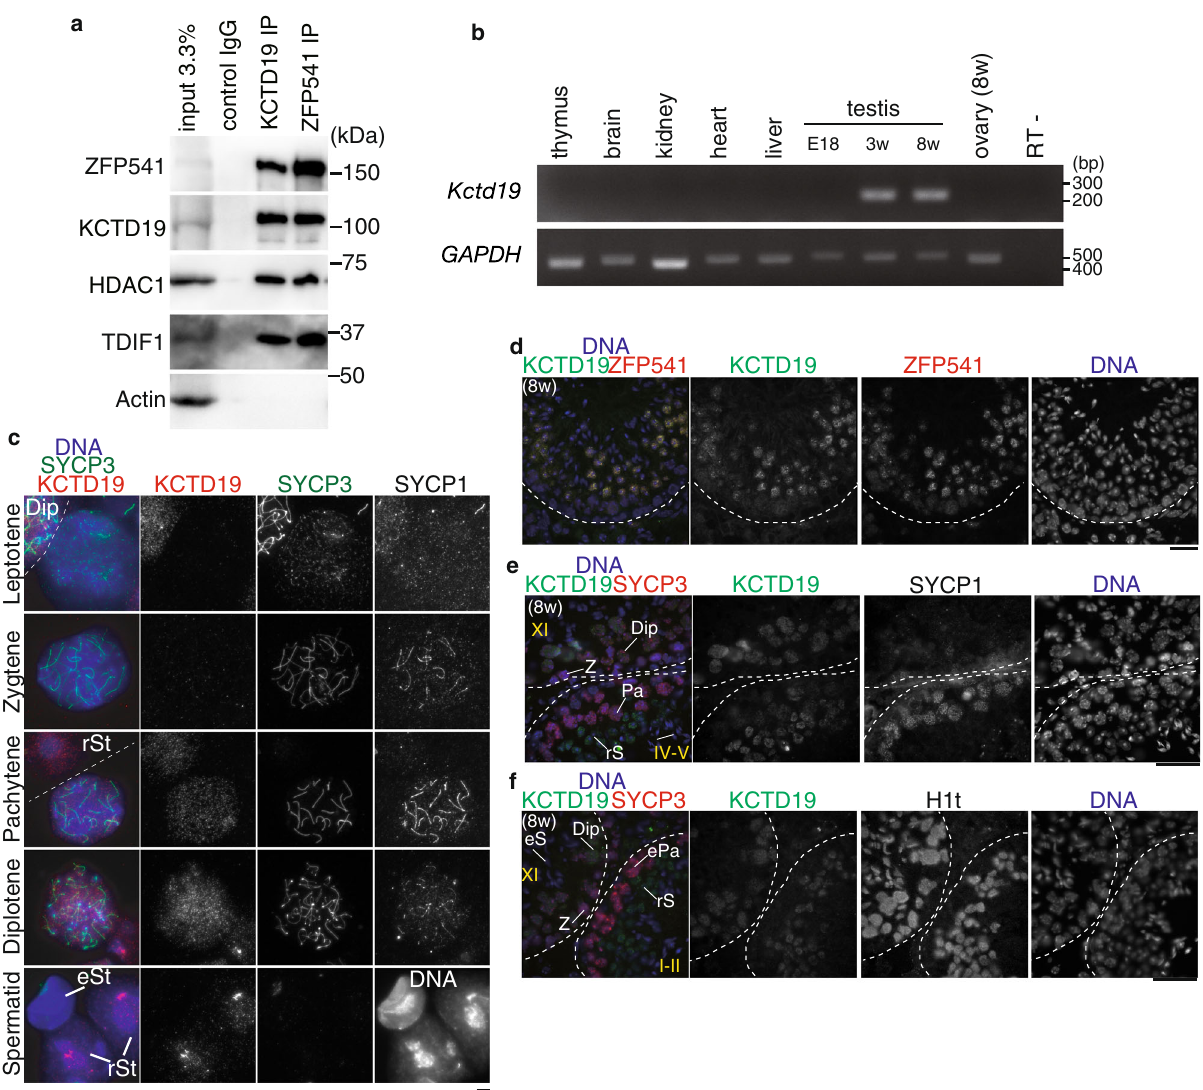
Fig. 4 KCTD19 was identi fi ed as a ZFP541-interacting factor in the testis. a Immunoblot showing the immunoprecipitates of ZFP541 and KCTD19 from chromatin extracts of WT mouse testes. The data were acquired from two separate experiments. b The tissue-speci fi c expression pattern of Kctd19 was examined using RT-PCR. Testis RNA was obtained from embryonic day 18 (E18), 3-weeks old (3w), and 8-weeks old (8w) male mice. Ovary RNA was obtained from adult 8-weeks old (8w) female mice. RT − indicates control PCR without reverse transcription. The data were acquired from two